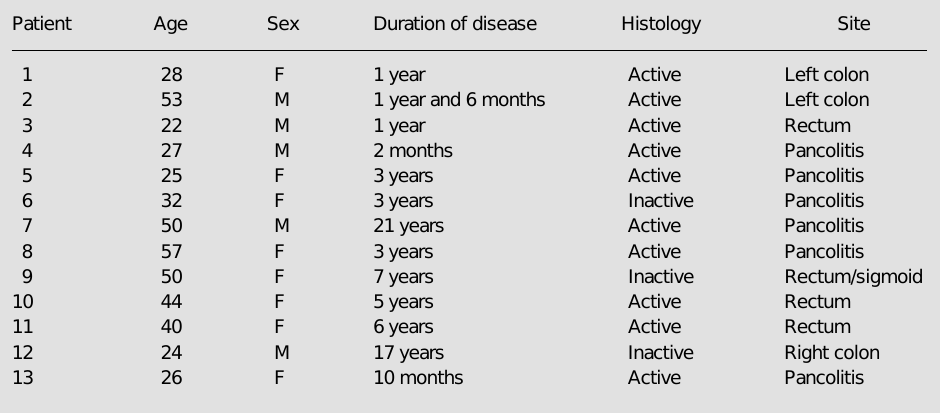
Table 1 - Clinical and pathological data. Patient